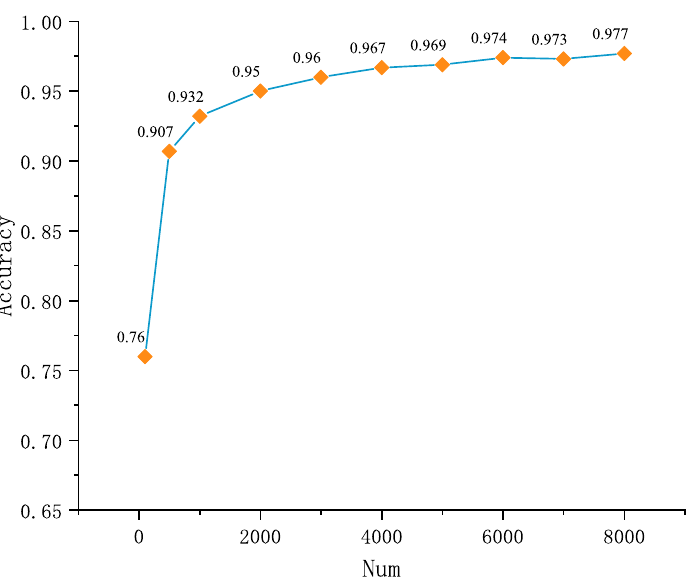
Figure 15. Accuracy achieved on the validation set by the model obtained after training with different number of data sets.